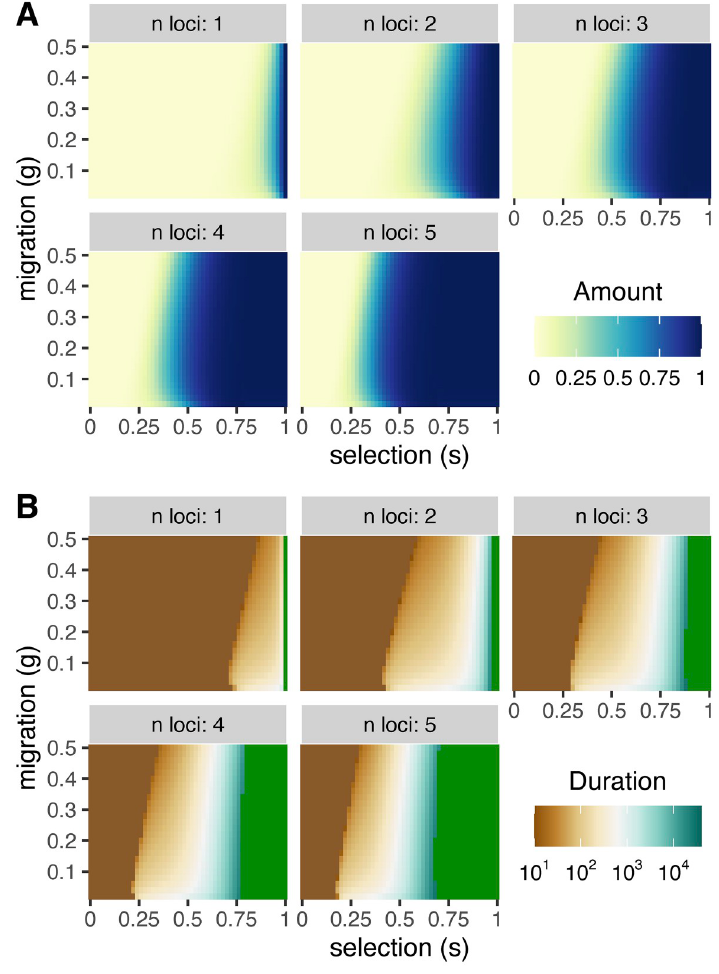
Fig 5. Oligogenic ecological selection. The maximum strength ( A ) and duration ( B ) of reinforcement with ecological selection at n loci, where all ecologically selected loci are unlinked to one another and to the gametophytic factor. The selection coefficient s against a maladaptive allele is multiplicative within and among loci—e.g., the fitness of an individual homozygous for the locally maladaptive allele at all n loci is (1 − s ) 2 n . Migration rate g is symmetric and ¼ 10 (cid:0) 4 . The data underlying this figure can be found in https://datadryad.org/stash/dataset/ recombination rate r MF